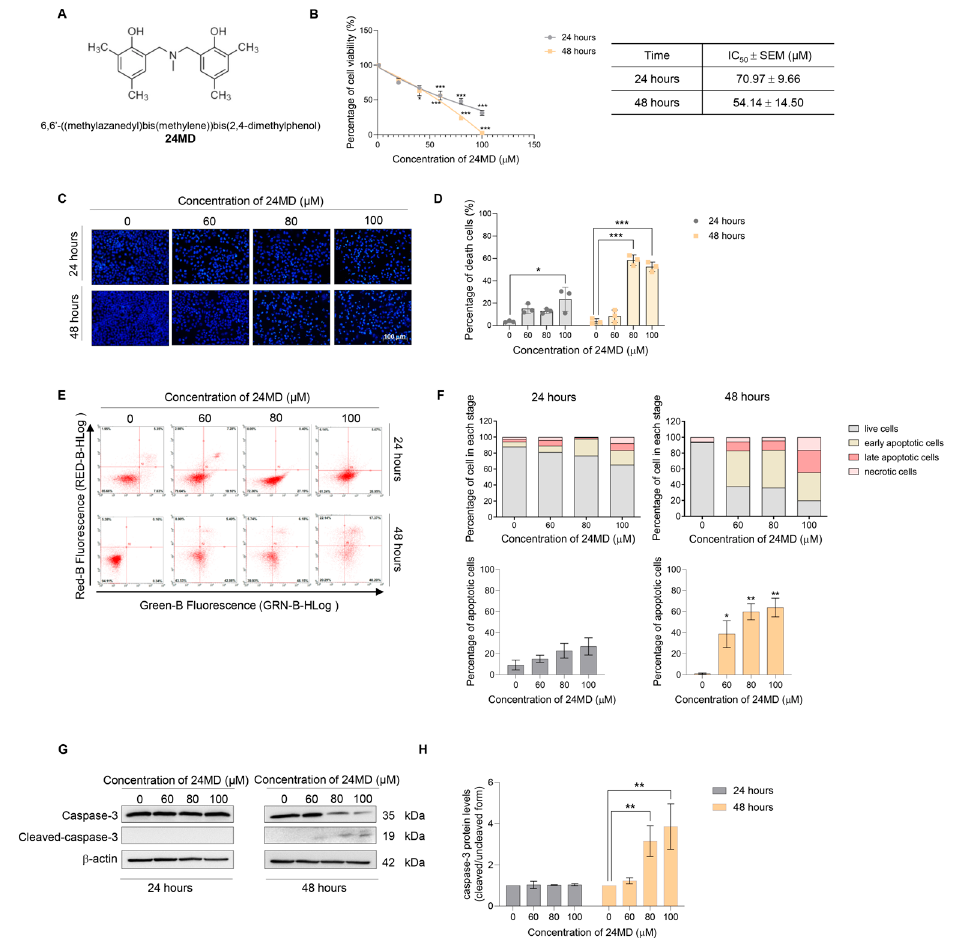
Figure 1. Effect of 24MD on cell viability and apoptosis inducing activity for 24 and 48 h of treatment. ( A ) the chemical structure of 24MD. ( B ) The MTT assay was performed to evaluate the cytotoxicity of 24MD. A549 cells were treated with various concentrations of 24MD (0–100 µ M) for 24 and 48 h. The percentage of cell viability was calculated by comparison with non-treatment control. The half maximal inhibitory concentration (IC 50 ) of 24MD at 24 and 48 h against A549 cells were estimated by using a linear regression equation. ( C , D ) Morphological changes of nucleus after treatment of 24MD (0–100 µ M) for 24 and 48 h were examined by nuclear staining assay with Hoechst 33342. Fragmented chromatin of apoptotic cells was visualized with condensed blue fluorescence. The percentage of apoptotic cells was calculated. ( E , F ) A549 cells were treated with 24MD (0–100 µ M) for 24 and 48 h before being subjected to evaluate apoptosis inducing activity by flow cytometry with annexin V FITC/propidium iodide (PI) staining. The percentage of cells in each stage and percentage of apoptotic cell death were demonstrated. ( G , H ) Key molecular protein of apoptosis inducing activity, caspase-3 was evaluated by Western blot analysis after 24MD (0–100 µ M) treatment for 24 and 48 h. Densitometric analysis was performed, and the result was represented in relative protein levels when compared with non-treatment control at each time point. β -actin protein was measured to confirm equal loading in each sample. The data are demonstrated as mean ± SEM ( n = 3) (* 0.01 ≤ p < 0.05, ** 0.001 ≤ p < 0.01 and *** p < 0.001 when compared with non-treatment control). Flow cytometry with Annexin V FITC/PI was performed to confirm the